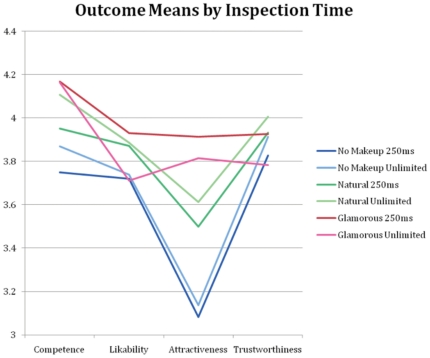
Means for the no makeup, natural and glamorous looks at 250 ms, and unlimited inspection times.